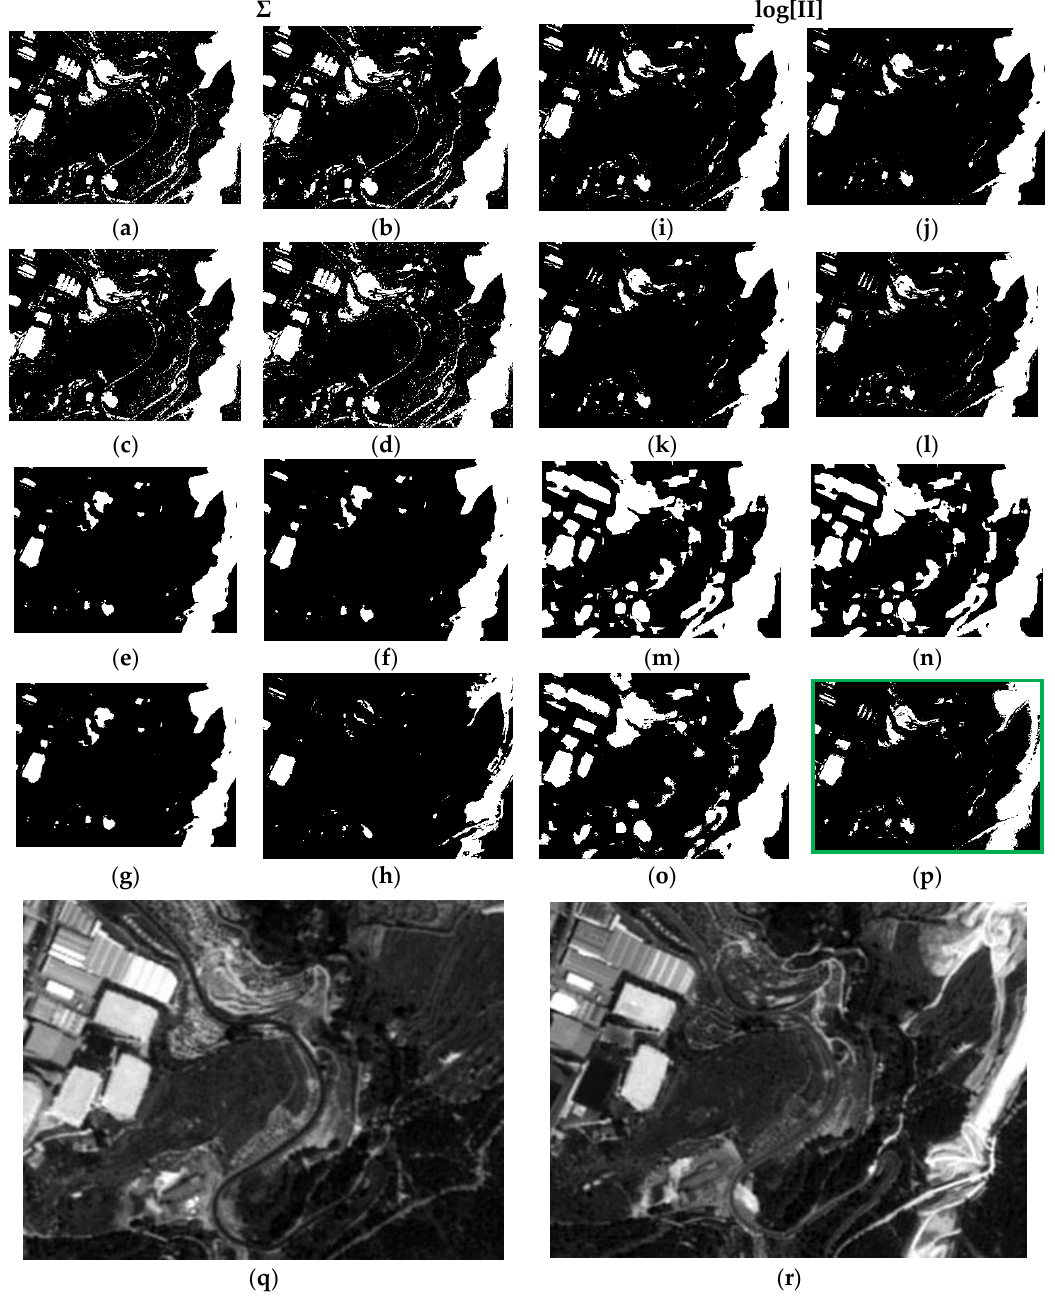
Figure 14. Probabilistic Information Fusion Results in DS2A2: ( a ) c1; ( b ) c2; ( c ) c3; ( d ) c4; ( e ) c5; ( f ) c6; ( g ) c7; ( h ) c8; ( i ) c9; ( j ) c10; ( k ) c11; ( l ) c12; ( m ) c13; ( n ) c14; ( o ) c15; ( p ) c16; ( q ) DS2A2 2005 SPOT-PAN image; ( r ) D2S2A2 2008 SPOT-PAN image.